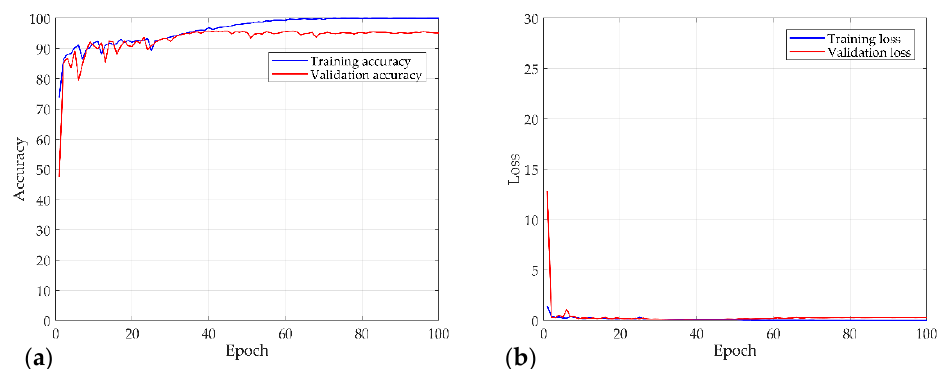
Figure 16. Results of the numerical experiment for the S&R model: ( a ) accuracy; ( b ) and loss curves over 100 epochs.